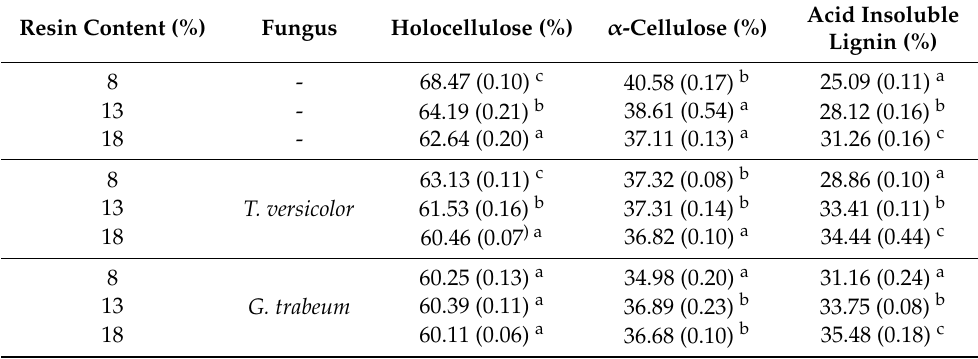
Values in parenthesis are standard deviations. For each parameter, average values with different letters ( a , b , c ) in each column indicate a significant difference at the 0.05 level (analysis of variance (ANOVA), followed by Duncan’s multiple range test). Table 2. Chemical compositions of OWMEC samples with different densities before and after 12 weeks of incubation with T. versicolor and G. trabeum fungi.